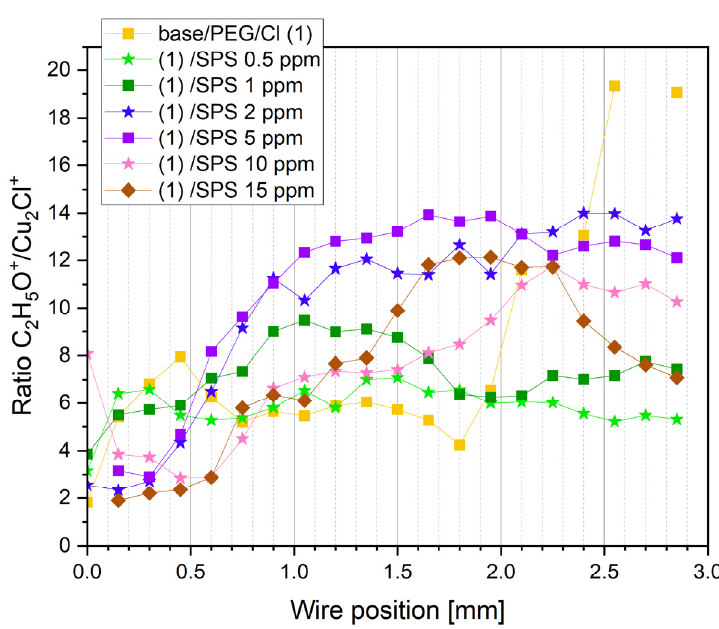
Figure 4. Distribution of the ratio of C 2 H 5 O + /Cu 2 Cl + as a function of the wire position for the base solution, base/PEG, base/PEG/Cl, and base/PEG/SPS at concentrations of 0.5, 1, 2, 5, 10, and 15 ppm.